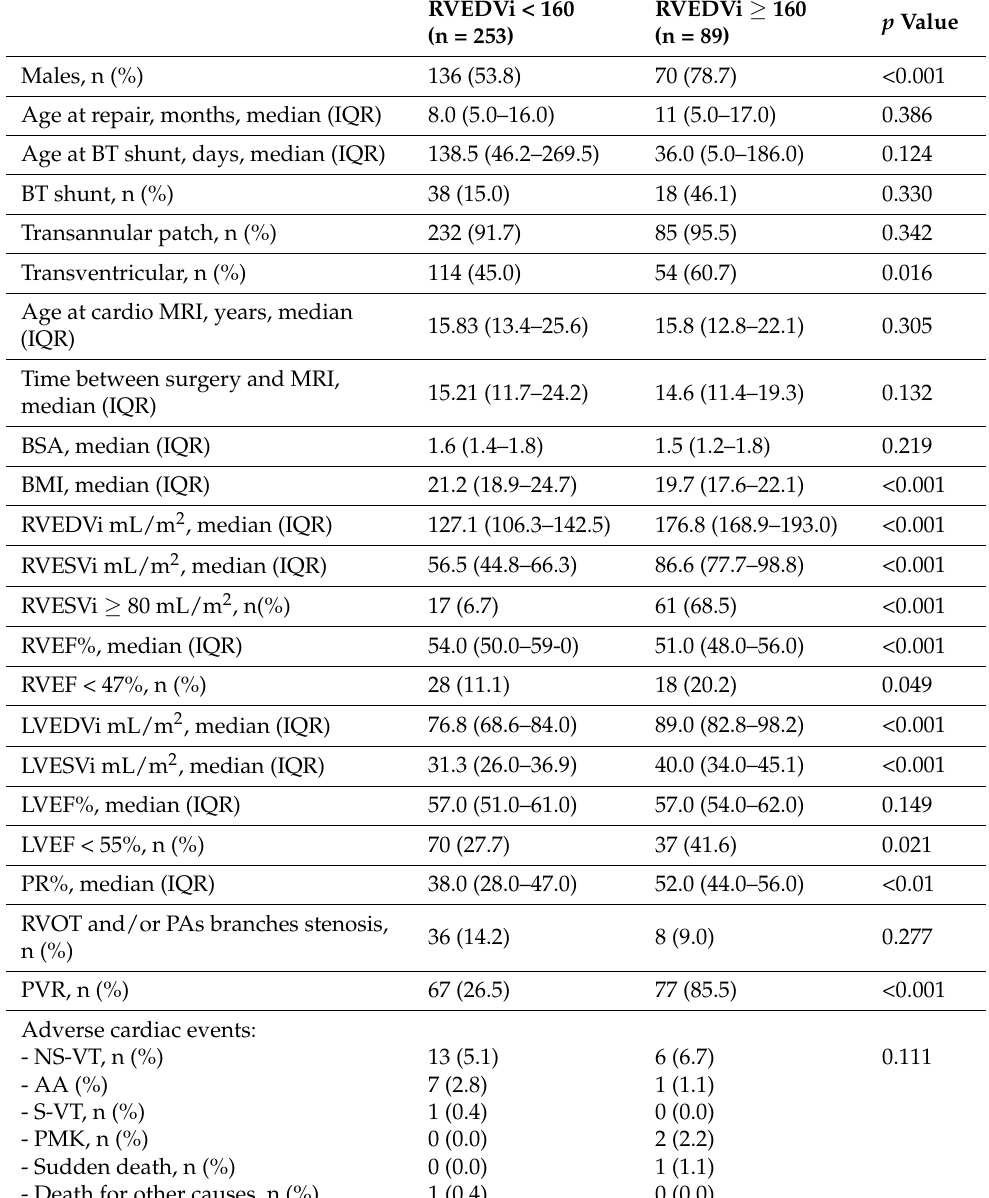
Table 4. Clinical and MRI characteristics according to RVEDVi ≥ 160 mL/m 2 . Legend: BT shunt = Blalock–Taussig shunt; TP = transannular patch; BSA = body surface area; BMI = body mass index; RVEDVi = right ventricular end-diastolic volume indexed by BSA; RVESVi = right ventricular end- systolic volume indexed by BSA; RVEF = right ventricular ejection fraction; LVEDVi = left ventricular end-diastolic volume indexed by BSA; LVESVi = left ventricular end-systolic volume indexed by BSA; LVEF = left ventricular ejection fraction; PR = pulmonary regurgitation fraction; RVOT = right ventricular outflow tract; PAs = pulmonary arteries; PVR = pulmonary valve replacement; NS-VT = non-sustained ventricular arrhythmias; S-VT = sustained ventricular arrhythmias; AA = atrial arrhythmia; PMK =